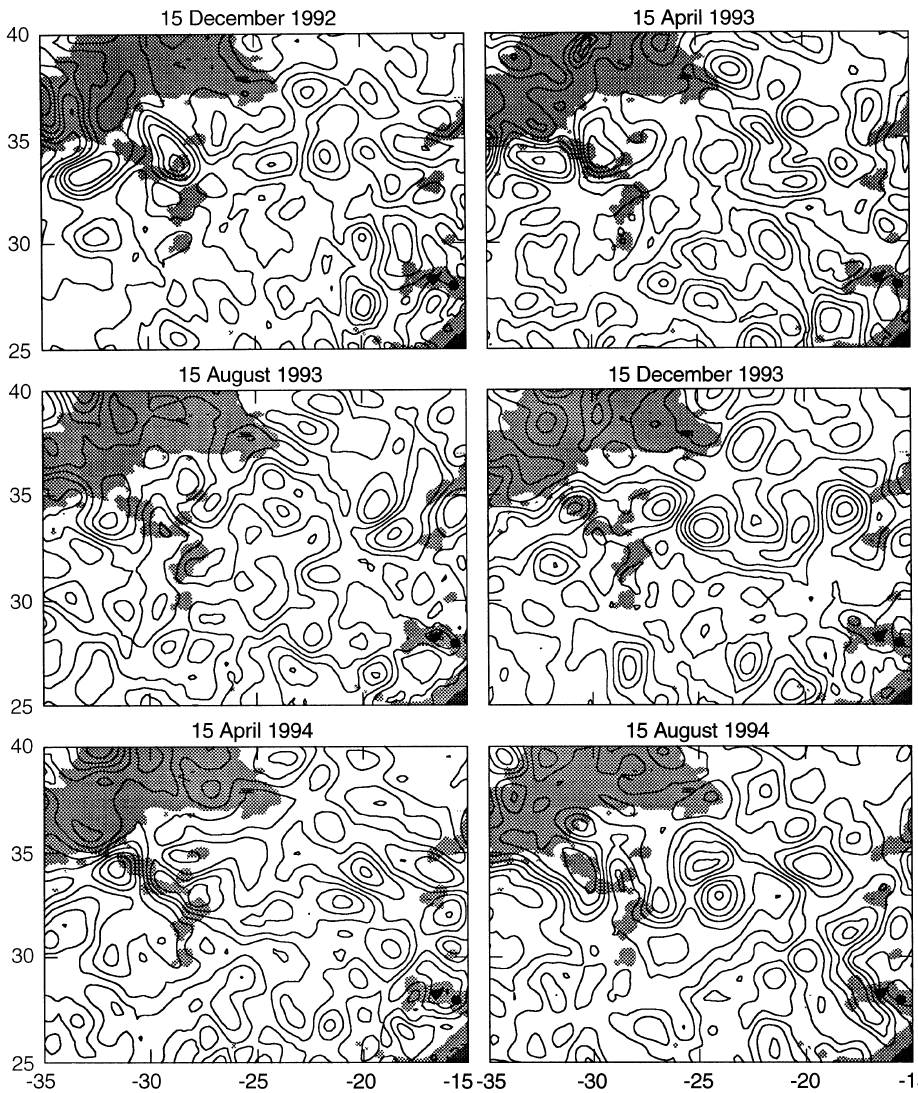
Fig. 3. Instantaneous surface transport (0–1000 m) in the Azores region as predicted by the model on Dec. 15, 1992, Apr. 15, 1993, Aug. 15, 1993, Dec. 15, 1993, Apr. 15, 1994 and Aug. 15, 1994. (CI: 2 Sv). Shading corresponds to the re- gions where the depth is less than